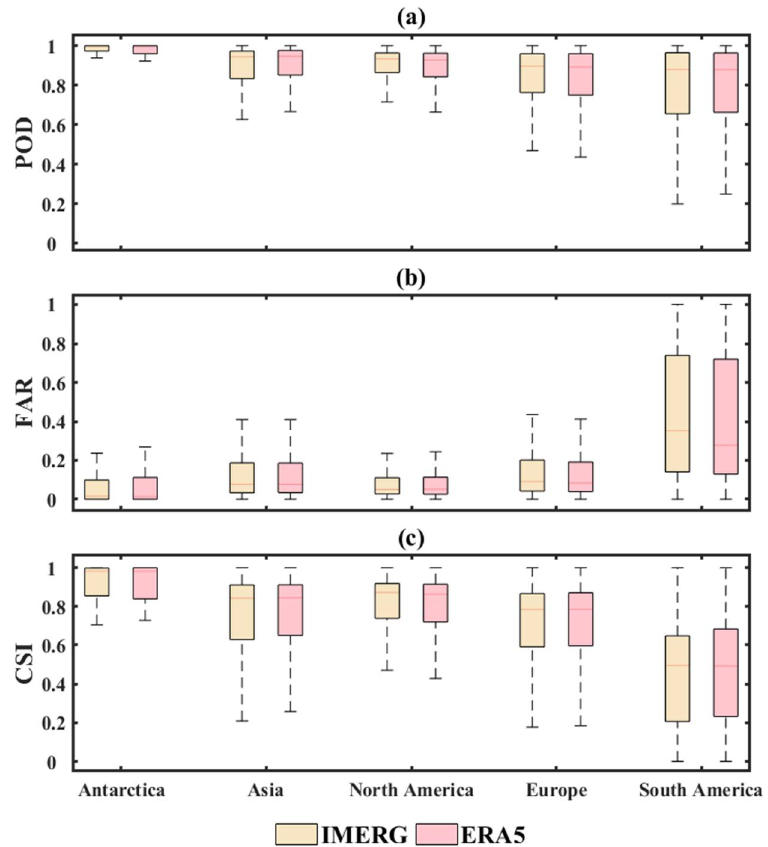
Figure 6. Boxplots of POD, FAR, and CSI metrics of main global areas for ERA5 and IMERG products. ( a ) POD. ( b ) FAR. ( c ) CSI.